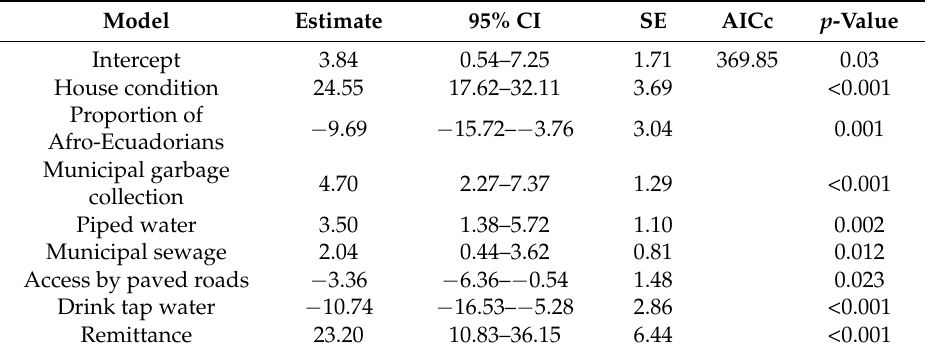
Table 2. Top logistic regression model used in determining which social-ecological factors are important to dengue presence.